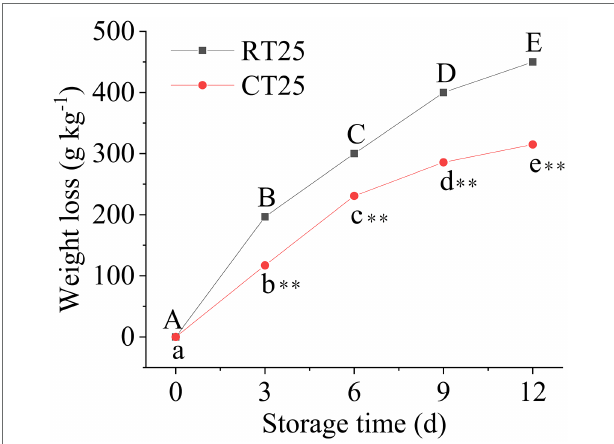
FIGURE 2 | Fresh-weight loss percentage in the postharvest shoots stored at 25 ° C and 4 ° C. Data are presented as mean ± standard deviation ( n = 3). Significant analysis was performed using the Student’s t -test, in which different letters represent significant difference between treatments within the group, and the asterisk represents the level of significance between groups ( * means the difference is significant at the 0.05 level, ** means the difference is significant at the 0.01